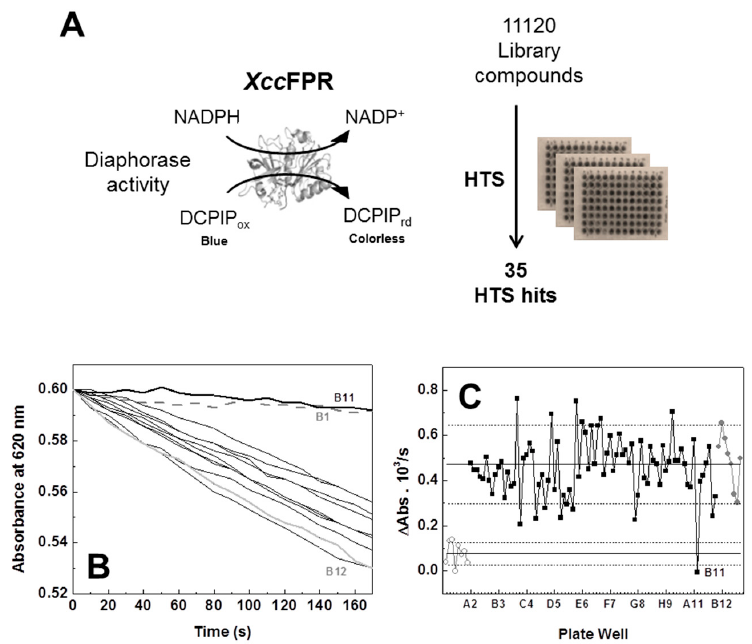
Figure 2. Activity-based high-throughput screening (HTS) for the discovery of the ferredoxin-NADP + reductase from Xanthomonas citri subsp. citri ( Xcc FPR) inhibitors. ( A ) Design of the activity assay and of the overall screening using as electron acceptor 2,6-dichlorophenolindophenol (DCPIP) and NADPH as electron donor. ( B ) Reaction kinetic traces for Row B of an HTS plate. Black lines correspond to wells containing library compounds (250 μ M), while grey ones correspond to the negative (dashed) and positive (solid) control wells. The line in dark bold corresponds to Well B11 (behaving similar to negative controls) and this compound was selected as a potential inhibitor of Xcc FPR. ( C ) Rates for the Xcc FPR diaphorase activity ( Δ Abs/s) calculated in each of the wells of one HTS plate. Data from wells containing library compounds are in black, while negative and positive controls are in grey open and grey closed circles, respectively. Solid lines represent negative and positive controls’ average velocities, and dotted lines are the average velocity plus and minus the standard deviation, respectively. The letter and number indicate the position of the well in the plate (row and column respectively) for the selected